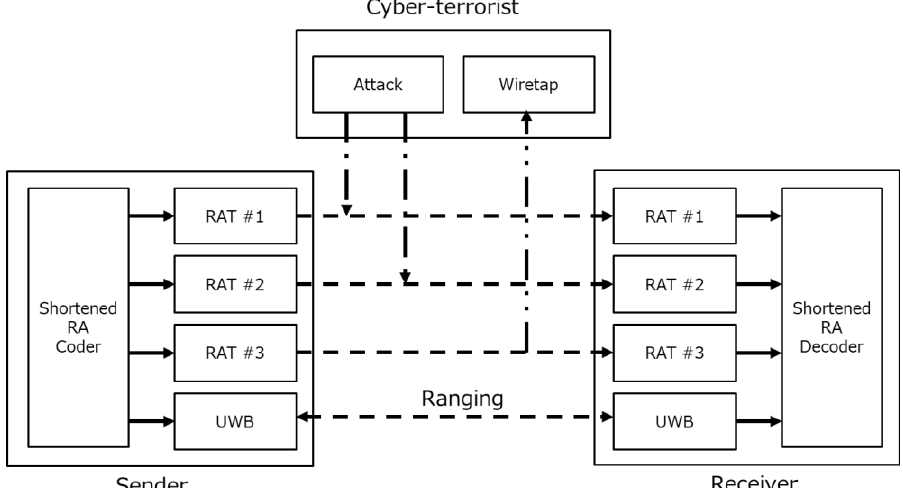
Figure 6. Evaluated simulation model with one sender, one receiver and one cyberterrorist. The sender and the receiver can use up to three RATs for communication.